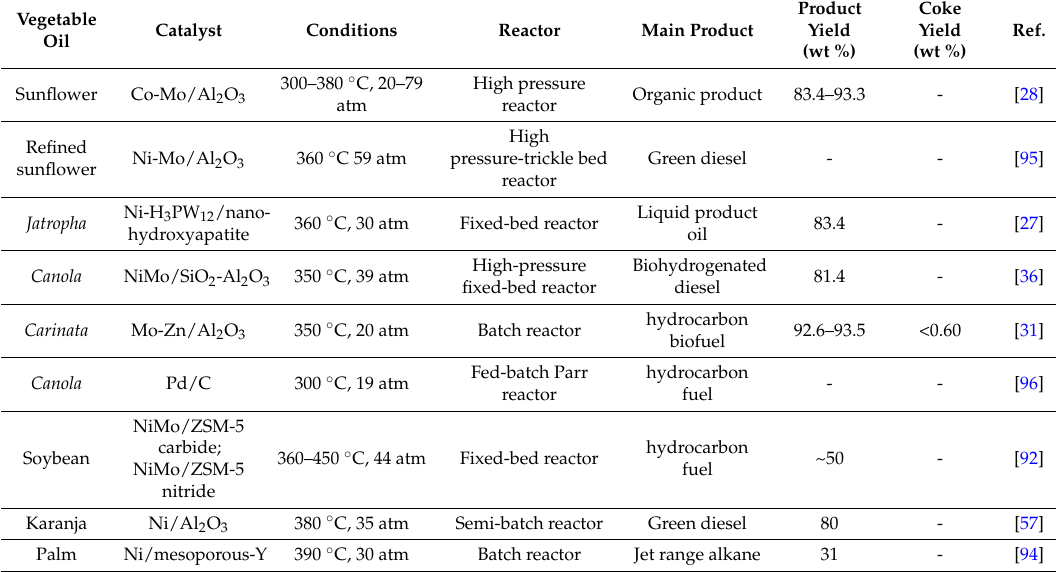
Table 6. Recent progresses in hydroprocessing of vegetable oil to hydrocarbon